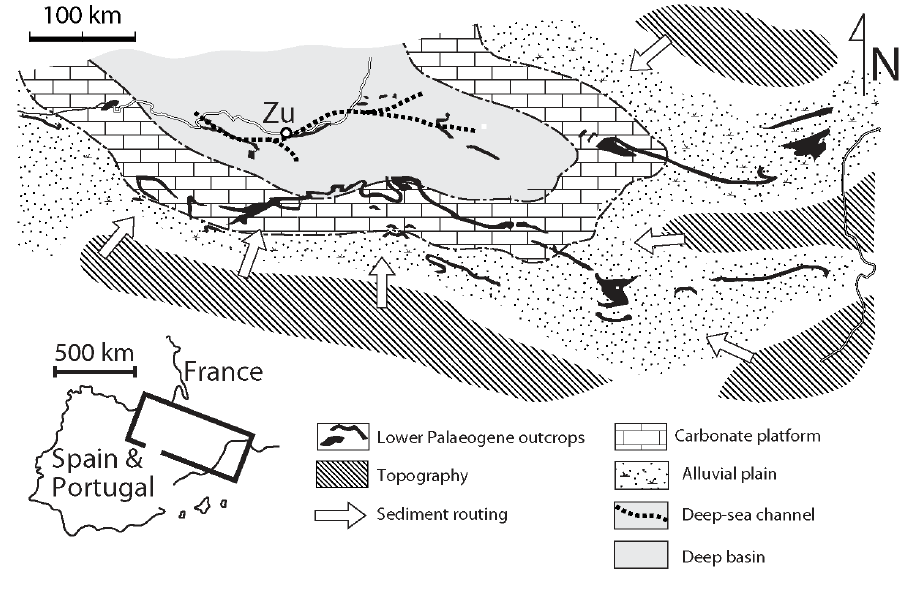
Figure 1. Location of Zumaia section and relationship to the terrestrial and shallow shelf carbonate depositional environments, after Pujalte et al.